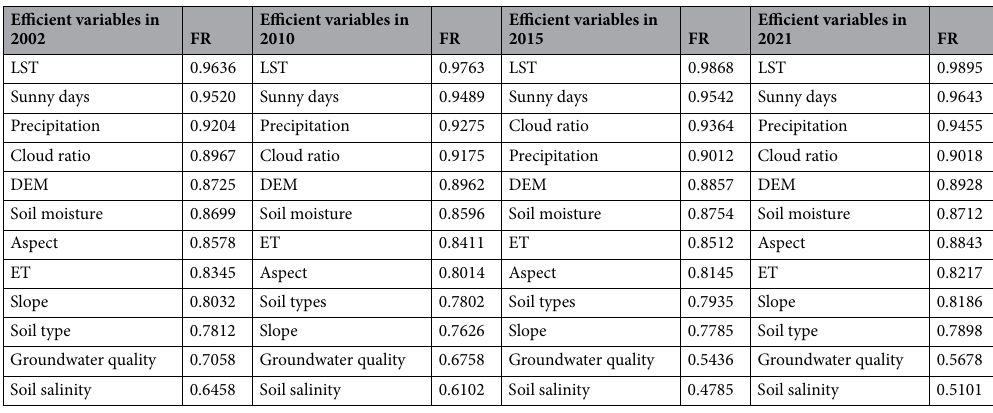
Table 11. Efficiency of different variables for frost-affected area modelling and mapping using the FR.